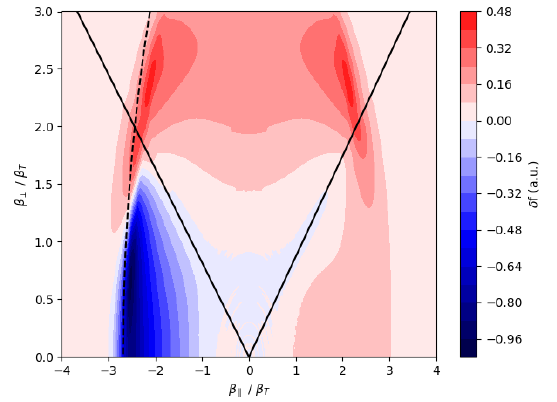
Figure 6. Perturbation in distribution function [a.u.] from Maxwellian at ρ = 0.88 for run giving the best current drive efficiency for SPR-008. 𝐼 𝐶𝐷 = −38.8 kA, 𝑁 ∥ = 0.64 and absorption is on 2 nd harmonic so Okhawa current drive is dominant. The resonance curve (dashed black) and trapped- passing boundary (solid black) are also shown.